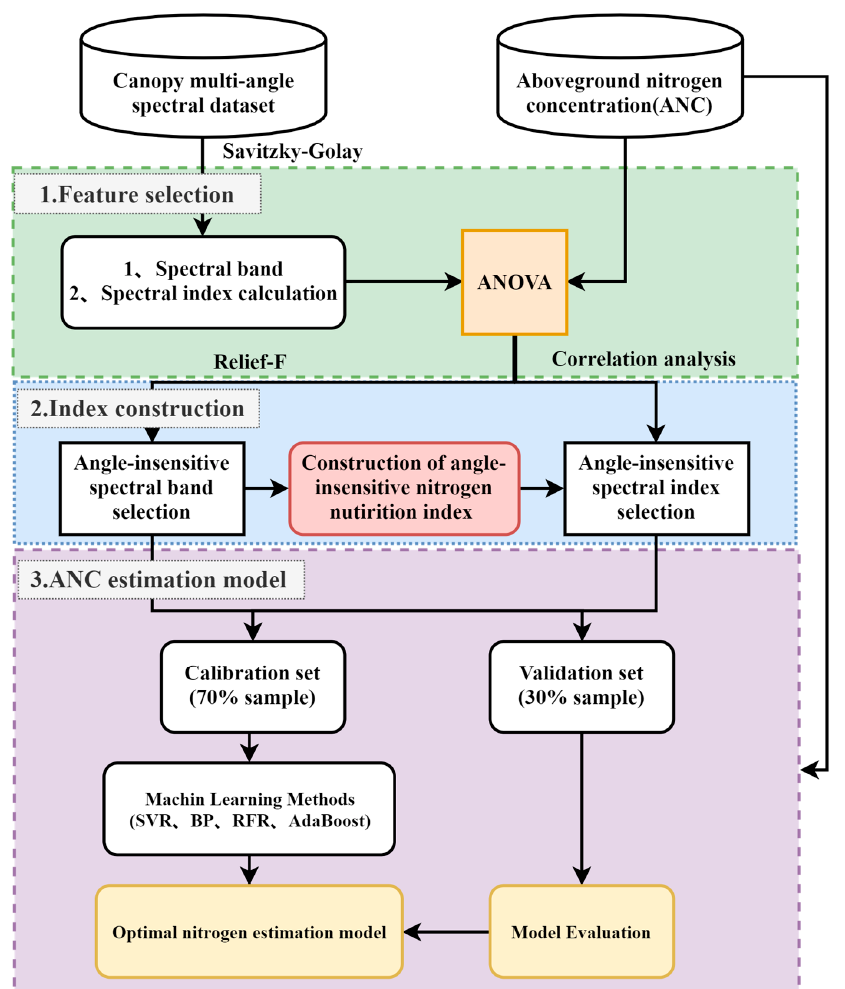
Figure 3. Schematic illustration of cotton ANC estimation based on multi-angle hyperspectral data and machine learning.